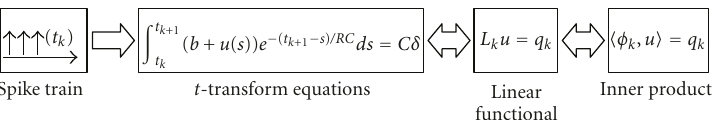
Figure 1: The operator interpretation of stimulus encoding with a LIF